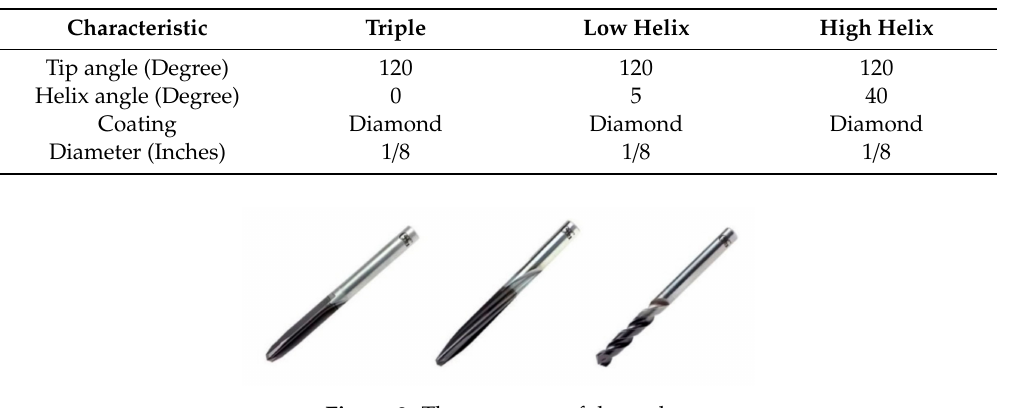
Figure 2. The geometry of the tool.